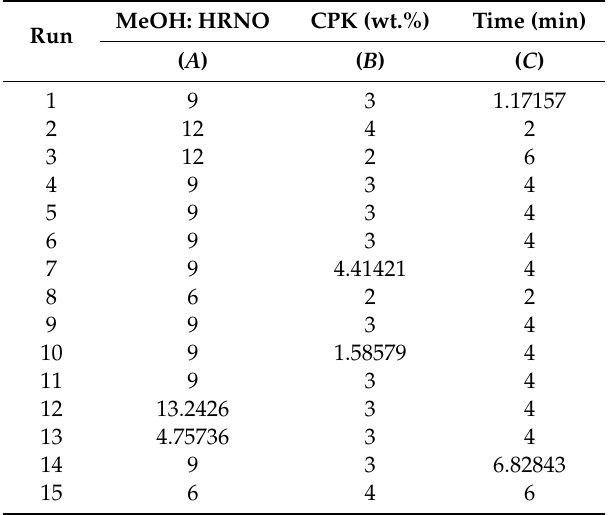
Table 9. Experimental design for HRNOB